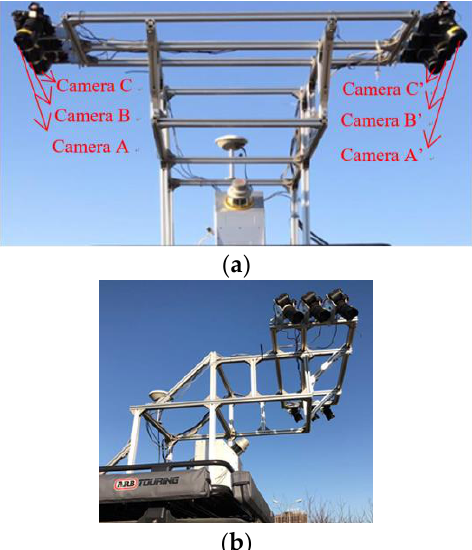
Figure 2. Structure of the reconstructed camera system and mounting frame. ( a ) Bottom view of the modified system. ( b ) Side view of the modified system.